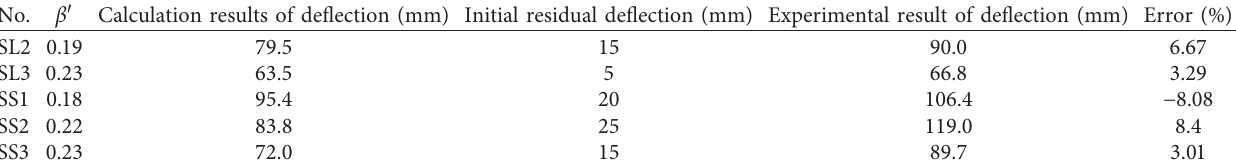
Table 5: Comparison of calculation results and experimental results of deflection.